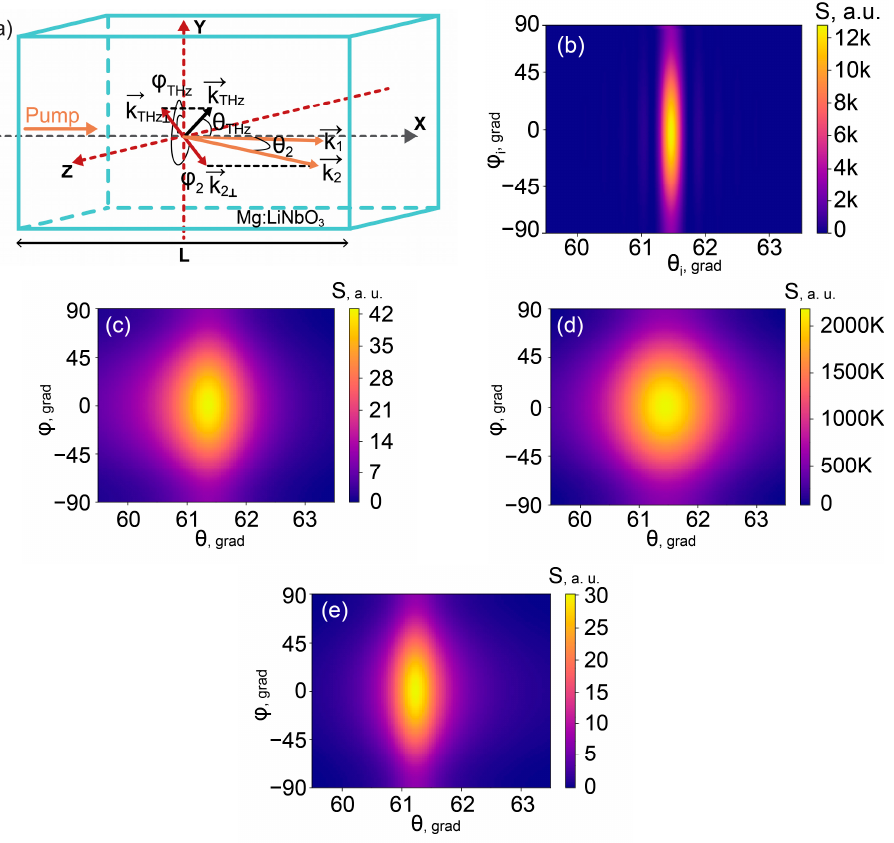
Figure 1. ( a ) Directions of laser and THz wave components in the crystal; angular distributions of the power density generated inside the crystal, calculated for ( b ) 1 THz, w p = 100 µ m, α THz = 0, ( c ) 1 THz, w p = 100 µ m, α THz = 13 cm − 1 , ( d ) 1 THz, w p = 5 µ m, α THz = 13 cm − 1 , and ( e ) 0.5 THz, w p = 100 µ m, α THz = 4 cm − 1 .